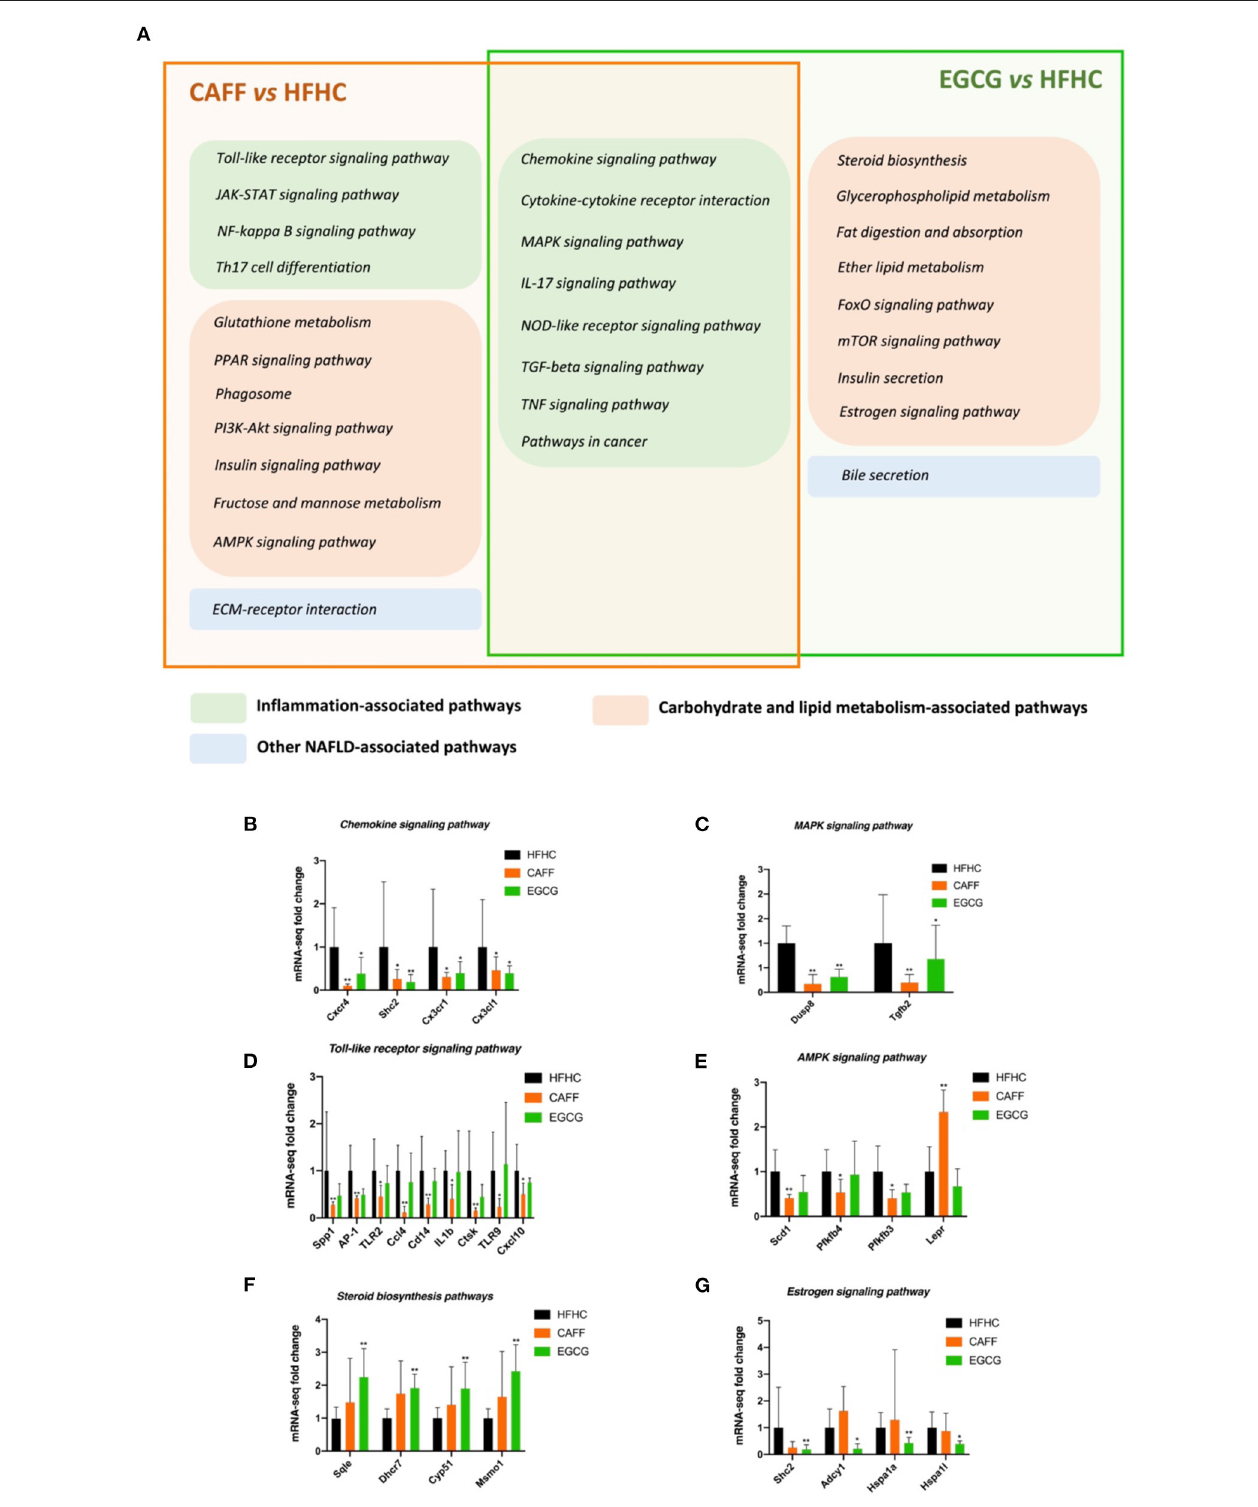
FIGURE 8 | The similarities and differences of the difference pathway between CAFF and HFHC and the difference pathway between EGCG and HFHC (A) . The mRNA-seq expression of differential genes in chemokine signaling pathway (B) , MAPK signaling pathway (C) , Toll-like receptor signaling pathway (D) , AMPK signaling pathway (E) , Steroid biosynthesis signaling pathway (F) , Estrogen signaling pathway (G) . vs. HFHC, * P < 0.05, ** P < 0.01.